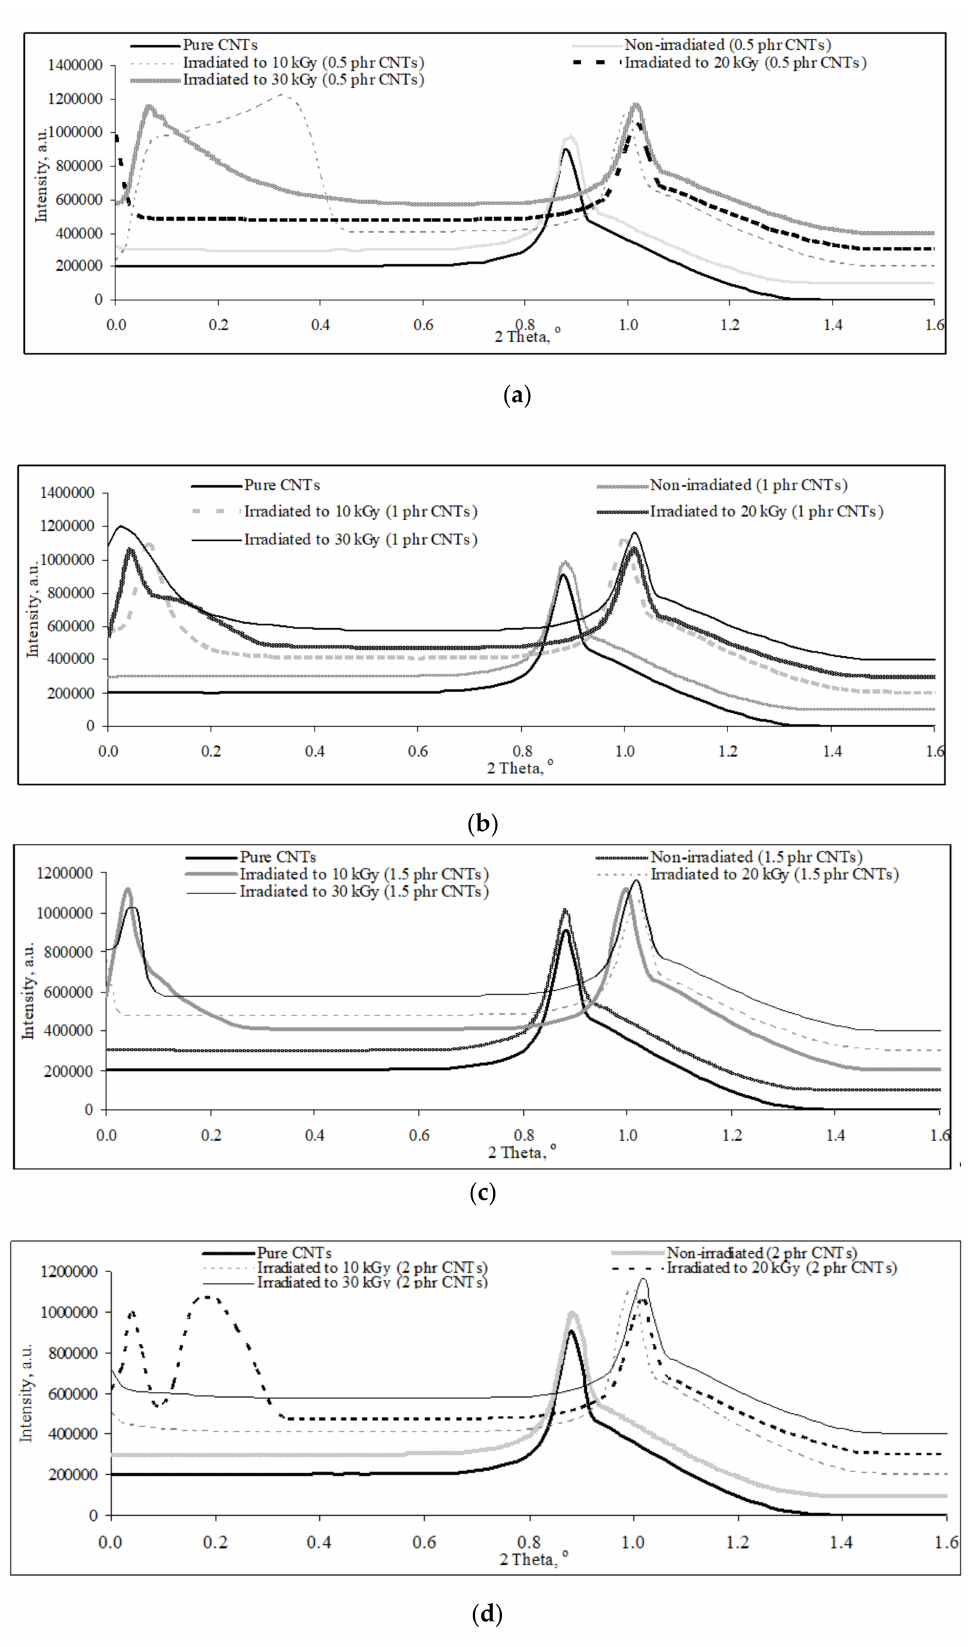
Figure 2. Effects of increasing loading level of carbon nanotubes (CNTs) on XRD curves for non-irradiated and irradiated polyvinyl alcohol (PVOH) nanocomposites. ( a ) 0.5 phr CNTs; ( b ) 1.0 phr CNTs; ( c ) 1.5 phr CNTs; ( d ) 2.0 phr